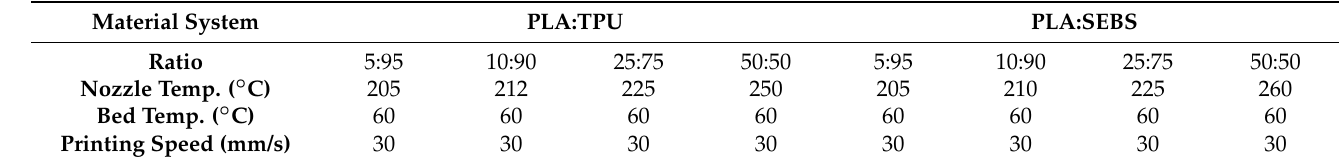
Table 2. Injection molding temperatures for the blends used in this study 1